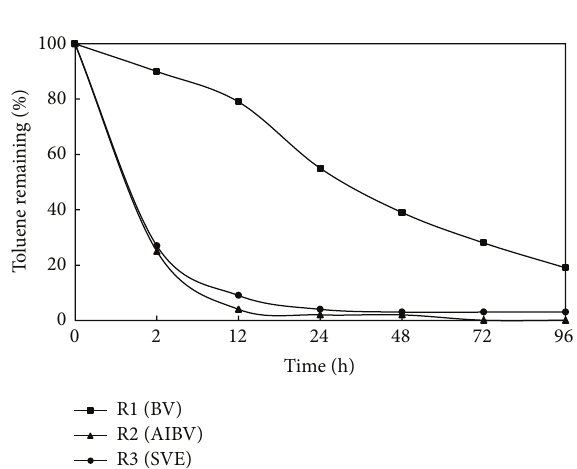
Figure 5: The effect of SWC on SVE (air flow rate = 250 mL/min; initial toluene conc. = 2mg/g soil). Figure 6: The efficiency of BV, SVE, and AIBV for toluene